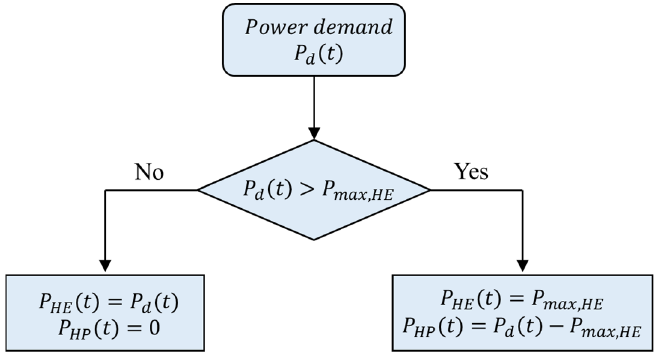
Figure 5. Rule ‐ based energy management strategy. Figure 5. Rule-based energy management